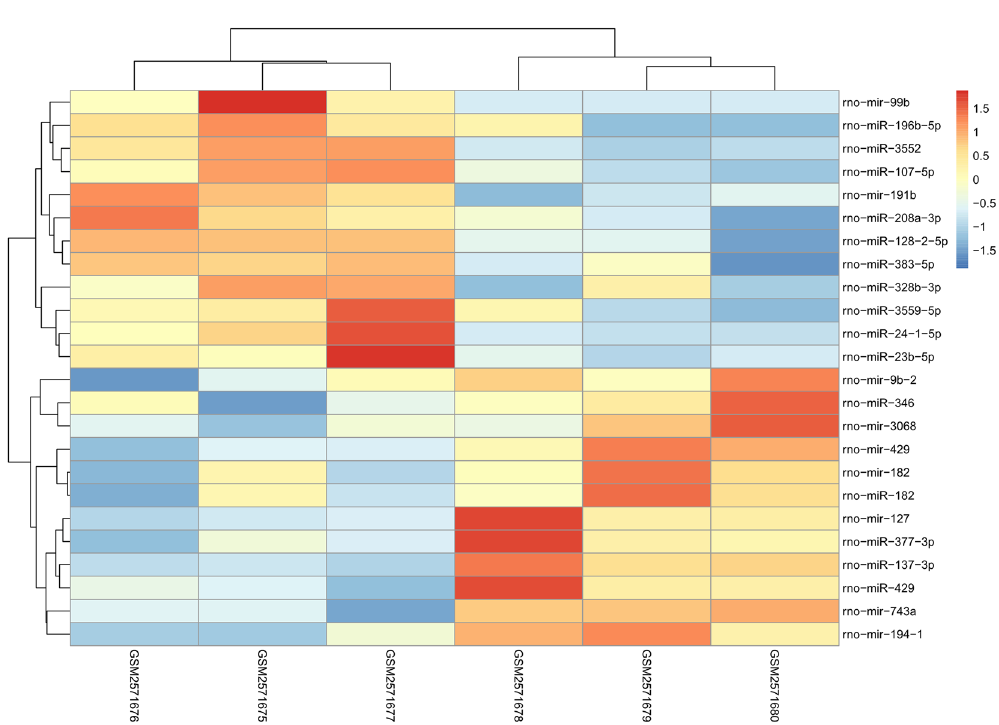
Figure 4. Heat map of DEMis. The left 3 samples were from Sham group, the right 3 samples were from MCAO group. The color from blue to red shows the progression from low expression to high